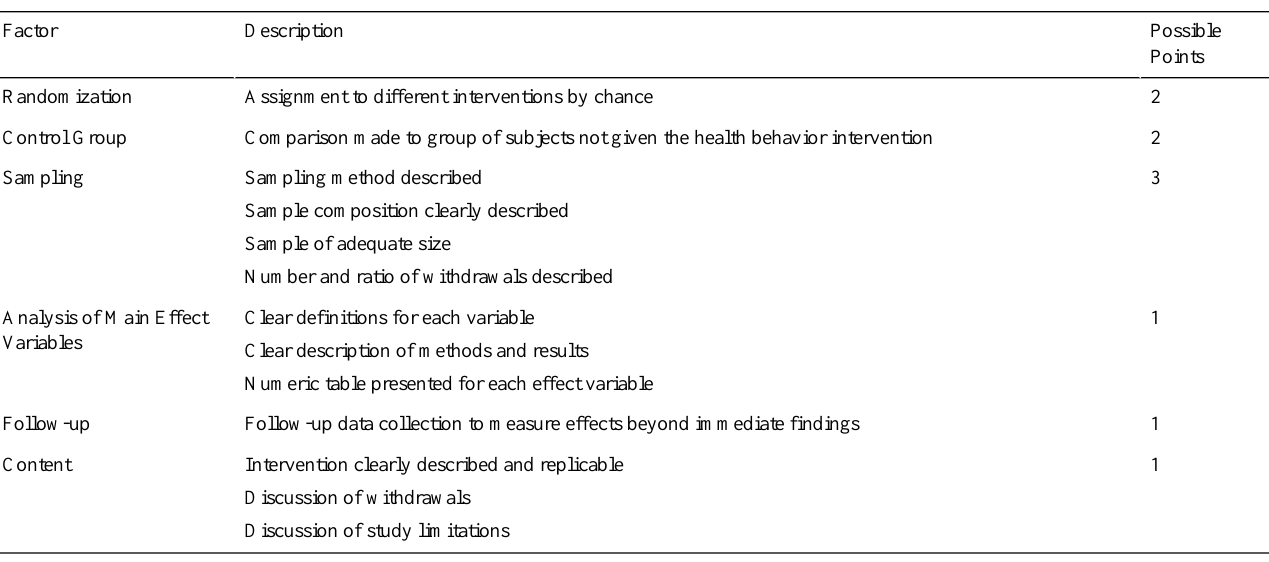
Table 1. Rating system